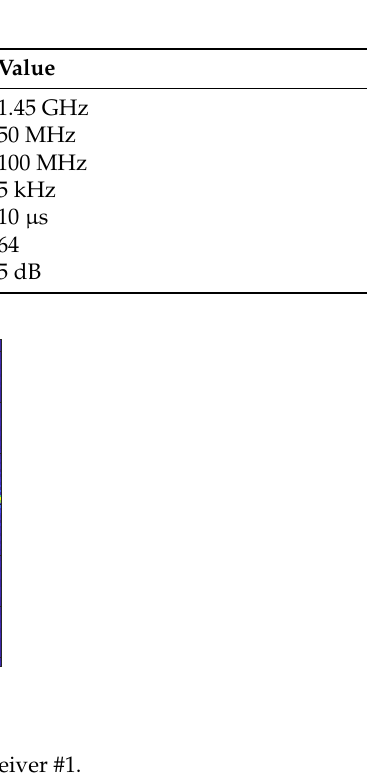
Figure 7. The result after the modified Keystone transformation. Figure 8 is the result after the azimuth compression. The red box indicates that the compressed data only occupies a small part of the range-Doppler plane. The data trans- mission is carried on after the azimuth compression. The data volume in the transmission is related to the width of the two first lobes of the compressed data, and the width is in- versely proportional to the signal bandwidth in the range domain. Thus, the amount of data to be transmitted is significantly reduced for a wideband signal.